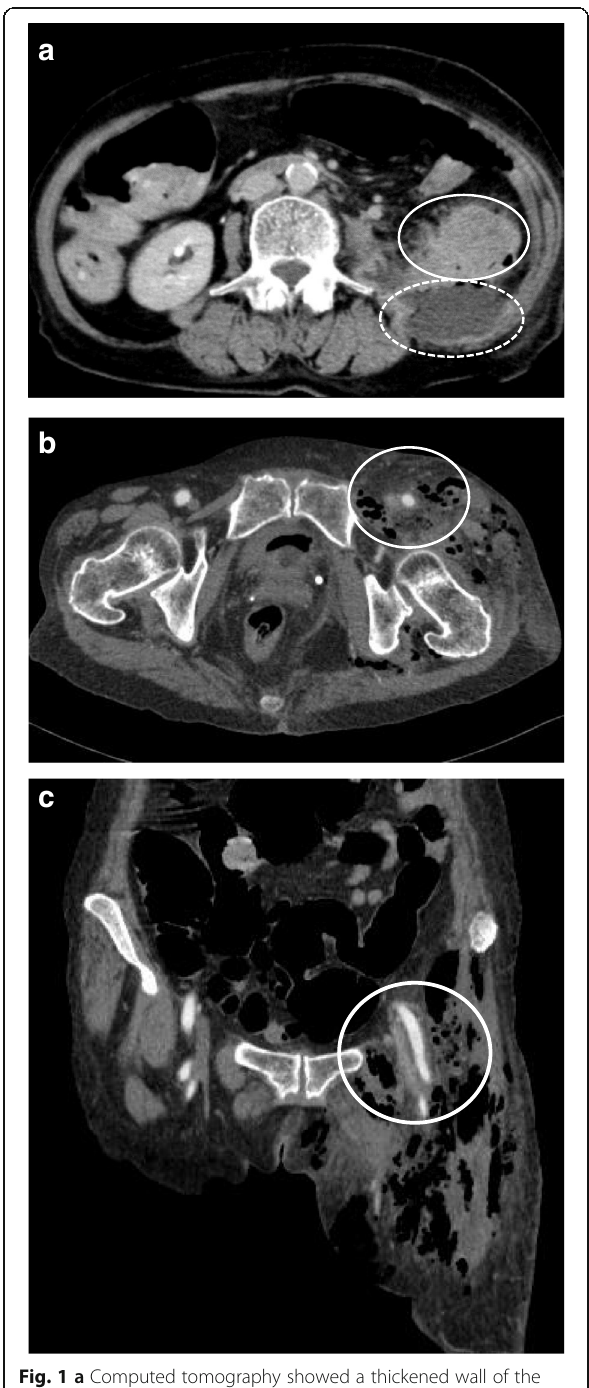
Fig. 1 a Computed tomography showed a thickened wall of the descending colon (circle) and abscess formation around this area (dotted circle). b , c Emphysema was present from the retroperitoneal abscess around the descending colon to the left thigh through the left femoral region